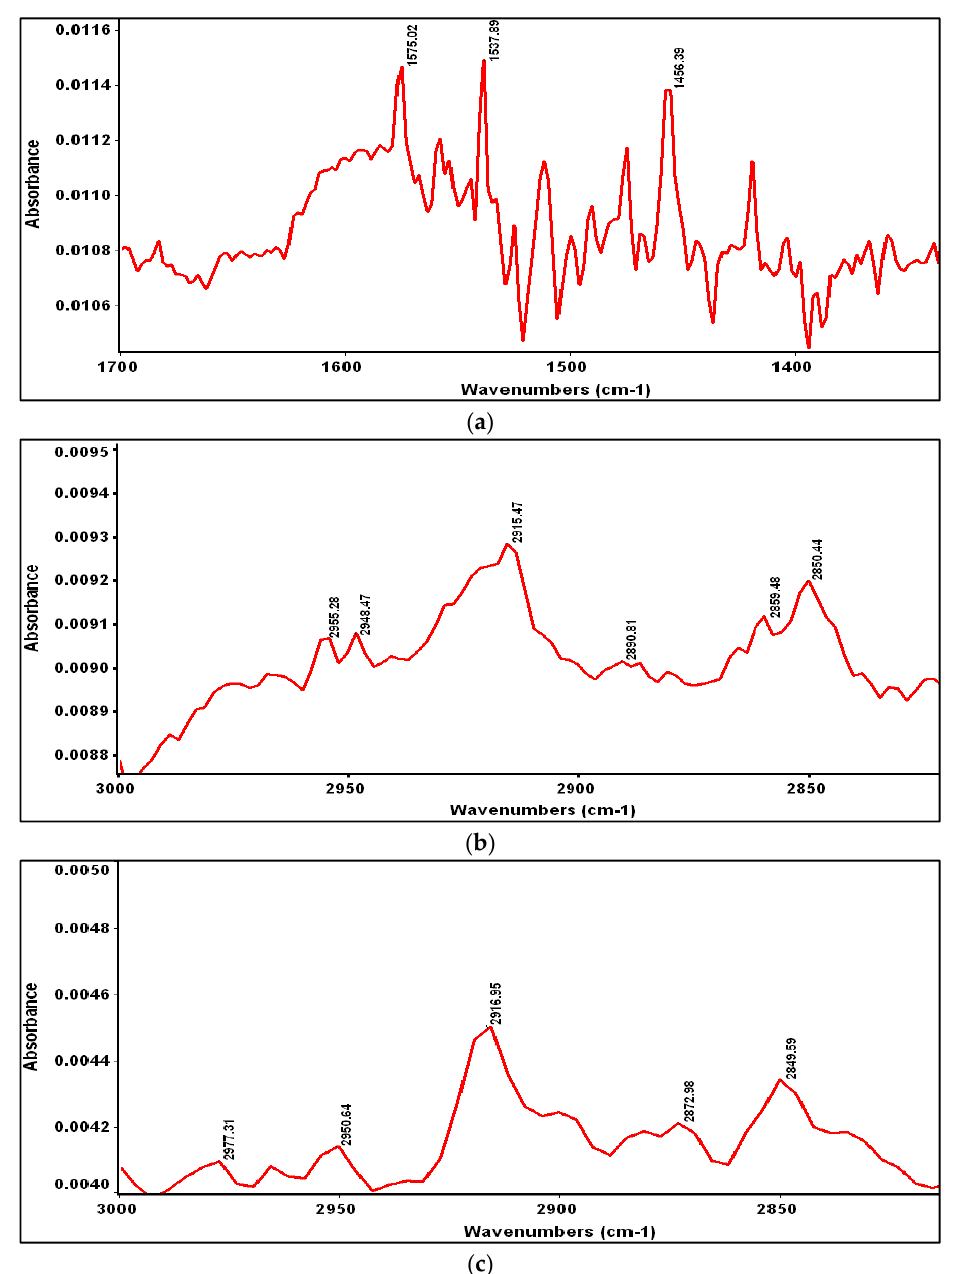
Figure 2. RAIRS spectra of ( a ) APTES (–NH 2 ) on silicon (Si); ( b ) ODT (–CH 3 ) on GaAs and ( c ) ODT (–CH 3 ) on ITO.